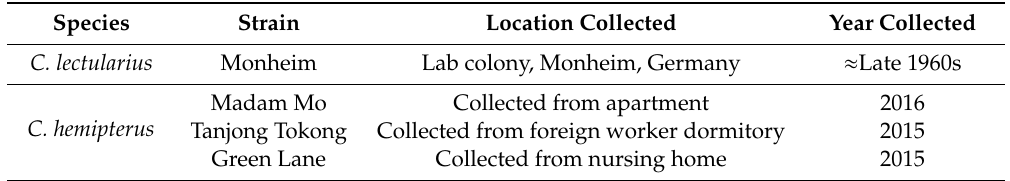
Table 1. Bed bug strains evaluated in this study.